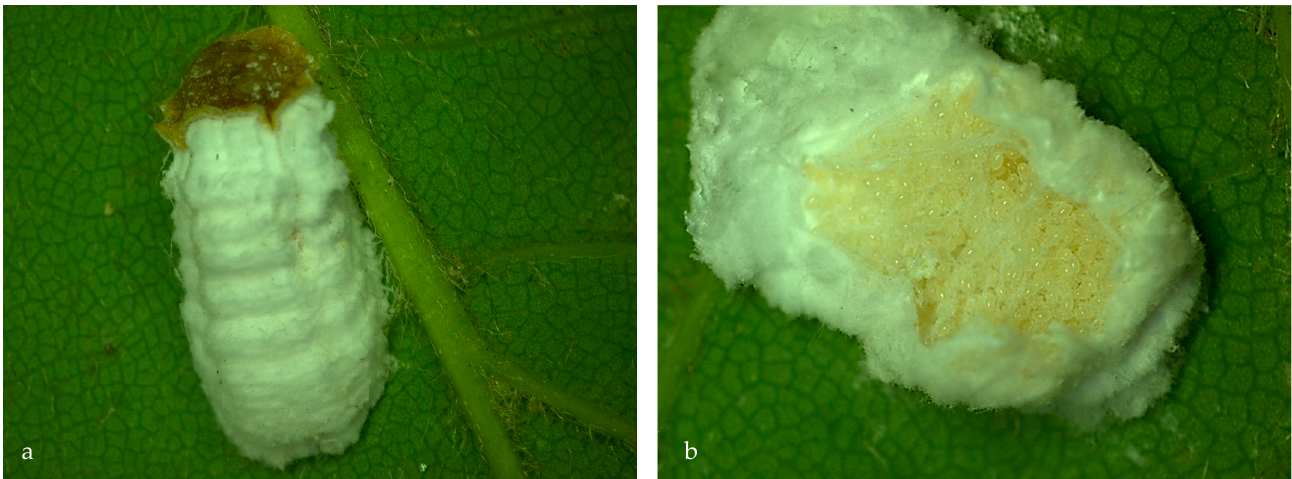
Figure 3. P. hydrangeae with ovisac: ( a ) visible parallel longitudinal strips and transversal ridges and ( b ) general aspect of the eggs laid inside the ovisac.